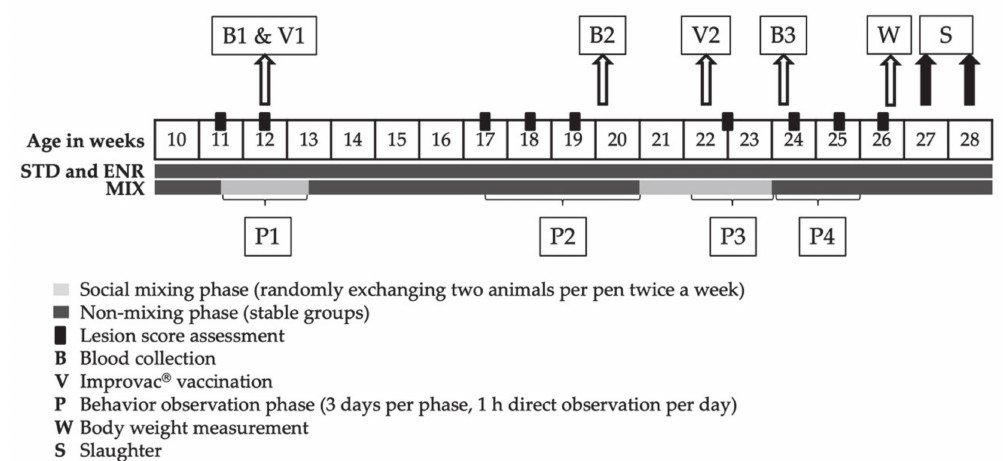
Figure 1. Experimental design of the study. Displayed are the animal’s weeks of age. Weeks, in which behavior observations occurred, are indicated with curly brackets. Mixing phases, where animals were exchanged in MIX pens every third day, are highlighted under the timeline in light grey, weeks without mixing have a dark grey background. Phases P1–P4 represent the following time points: P1: Pigs are about 80 days old, mixing carried out in the MIX pens, P2: Pigs are about 130 days old, no mixing carried out in the MIX pens, P3: Pigs are about 160 days old, mixing carried out in the MIX pens, P4: Pigs are about 170 days old, no mixing carried out in the MIX